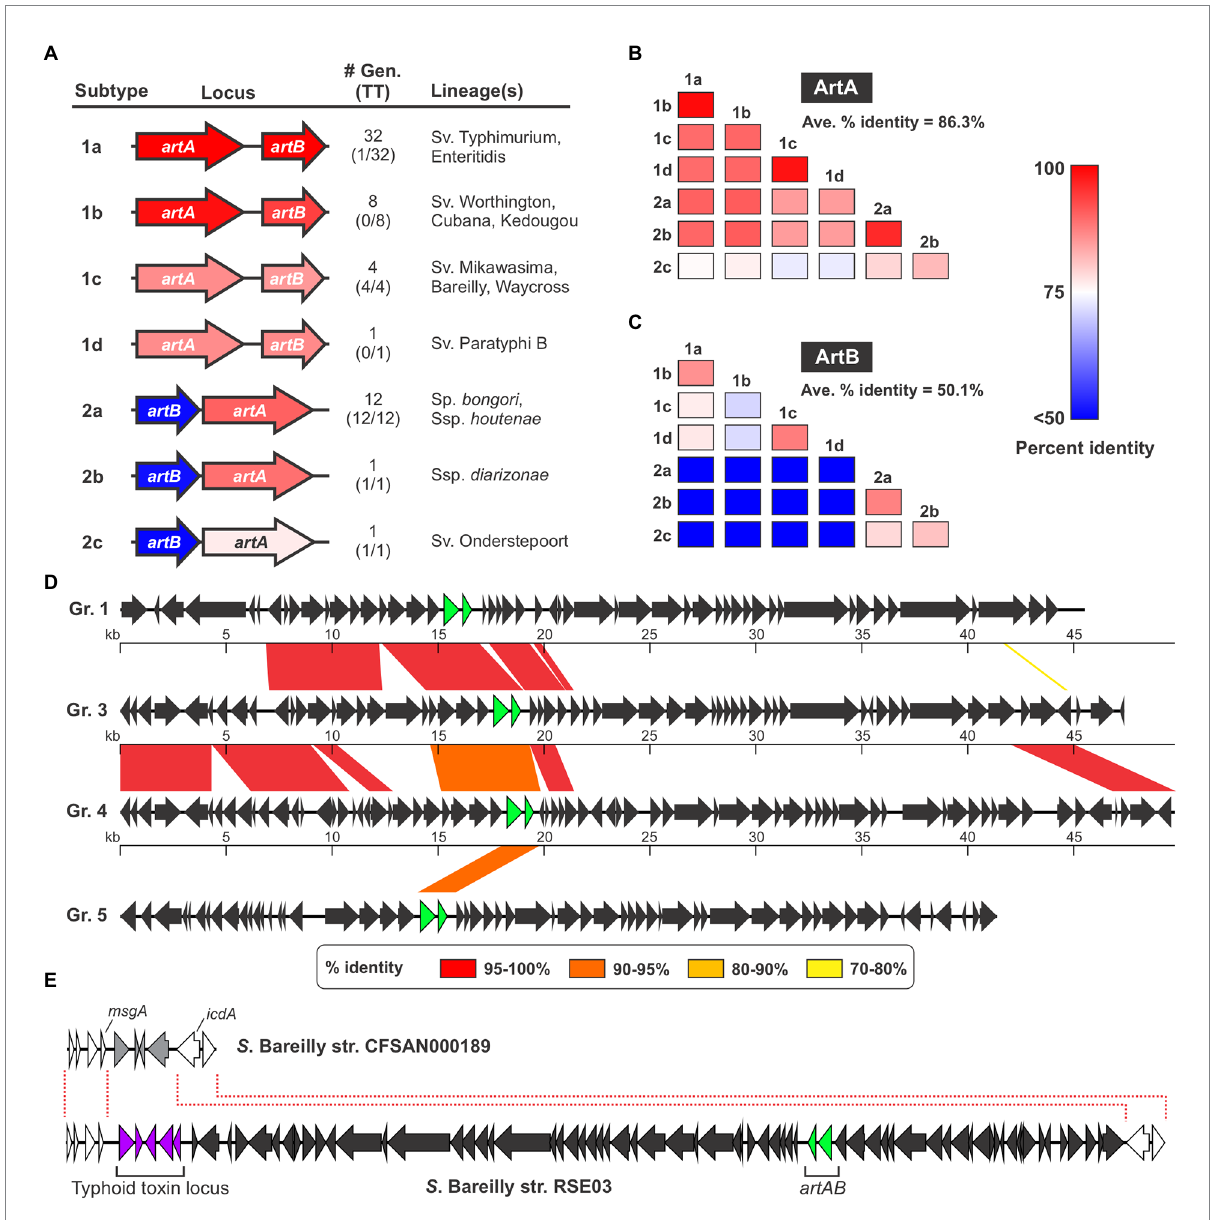
FIGURE 1 Several different ArtAB toxin subtypes are encoded by diverse prophages in Salmonella . (A) Summary of the seven ArtAB toxin subtypes identified in this study including: a gene diagram that uses a colour scale to show the percent sequence identities of the artA and artB genes compared to S . Typhimurium DT104 artA / artB , the number of genomes in the NCBI nr DNA sequence database that encode that subtype and how many of those genomes also encode a typhoid toxin islet [#Gen (TT)], and the Salmonella lineage (s) identified that encode this subtype. Percent identity values determined using a single representative of each toxin subtype, which is shown in Supplementary Dataset S1. (B,C) Percent amino acid sequence identity matrices comparing the different ArtAB toxin subtypes for ArtA (B) and ArtB (C) . Values generated using multiple sequence alignments of the representative member of each toxin subtype (see Supplementary Dataset S1). (D) Genome diagrams conveying the mosaic nature of the prophages that encode ArtAB toxins. Diagrams are shown for four representative ArtAB-encoding prophage groups (Gr.); regions of significant sequence similarity between combinations of these prophages are shown using a color scale to indicate the percent sequence identity. The artA and artB genes are shown in green. (E) Gene diagrams showing the Type 1c ArtAB toxin-encoding prophage locus in S . Bareilly strain RSE03, and the same genomic locus in a strain from this serovar that lacks this prophage. This comparison suggests that a typhoid toxin islet is part of the artAB -encoding